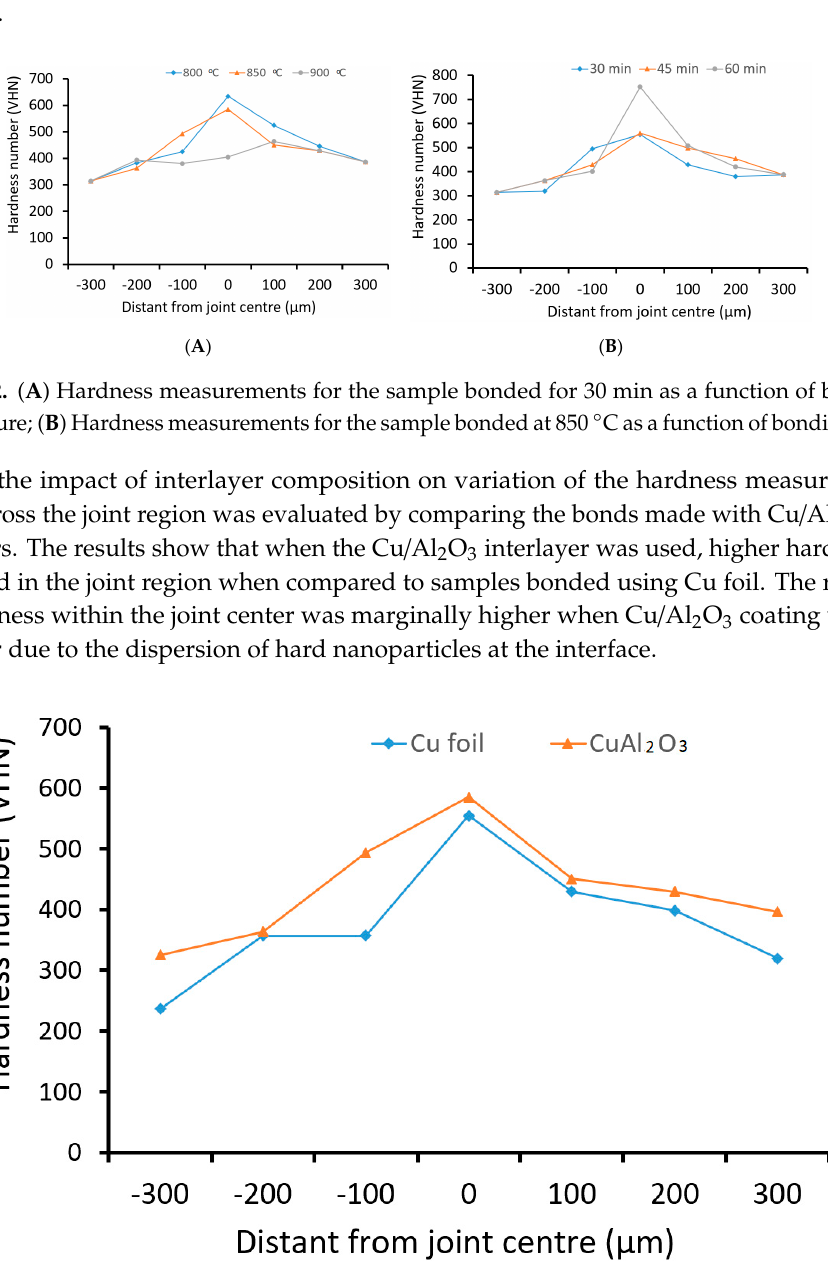
Figure 13. Hardness measurements as a function of interlayer composition for samples bonded at 850 °C for 30 min.